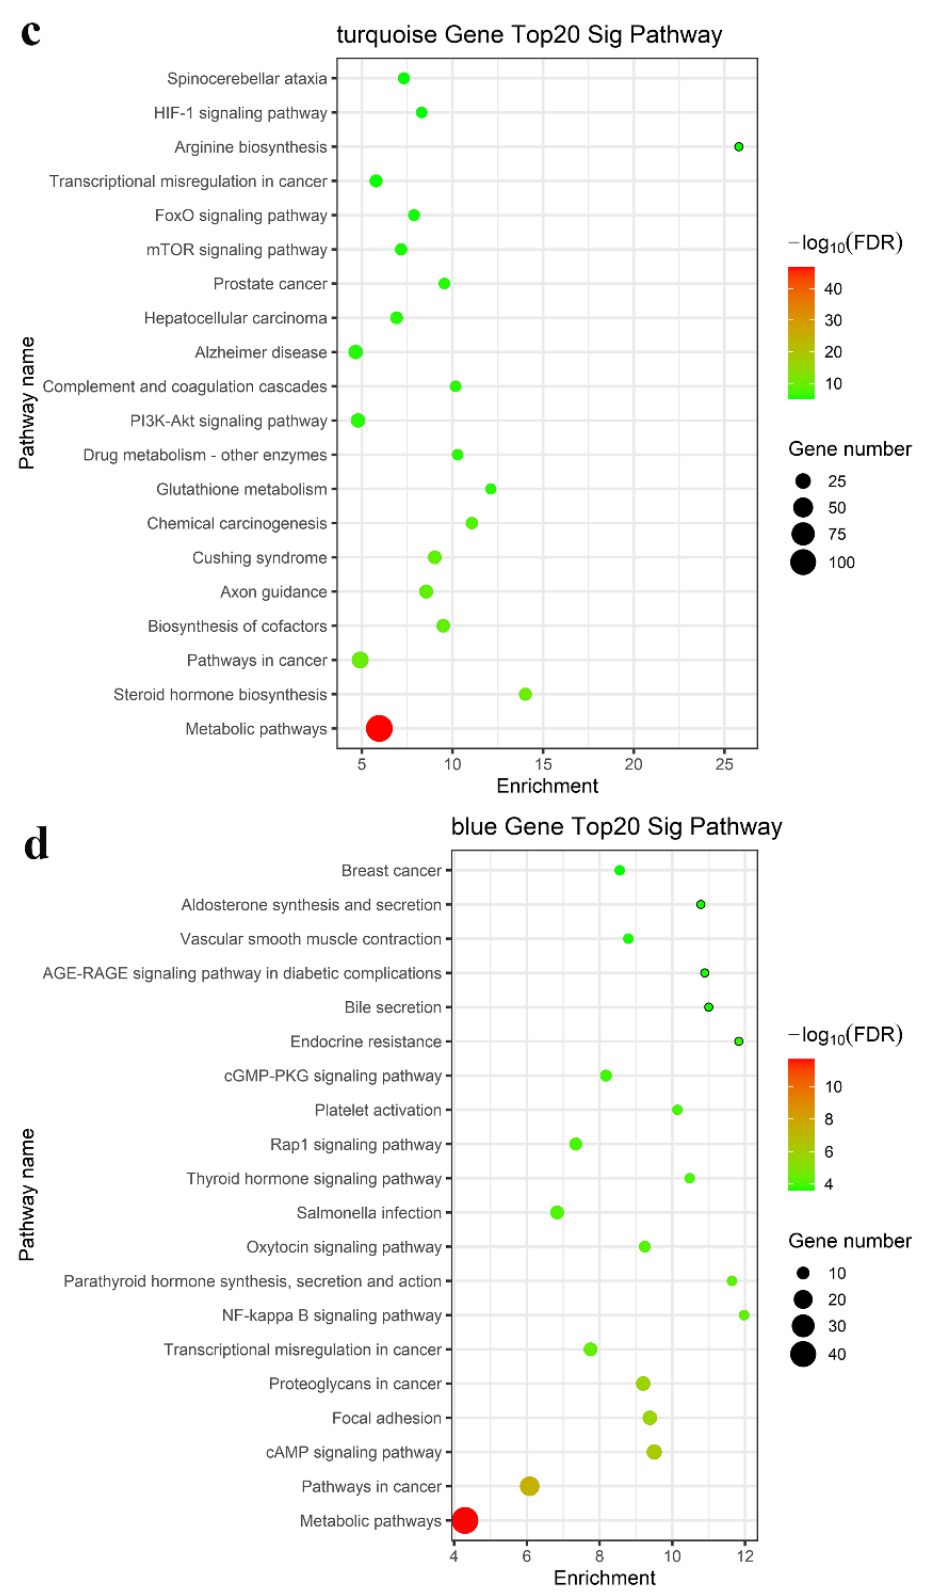
Figure 4. Functional enrichment analysis for the turquoise and blue modules. Enriched GO analysis of mRNAs in the ( a ) turquoise and ( b ) blue modules; enriched KEGG pathway analysis of mRNAs in the ( c ) turquoise module and ( d ) blue